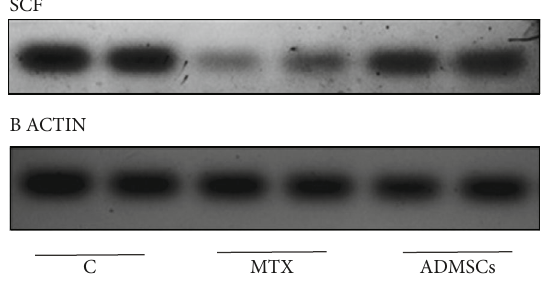
Figure 8: Western blot assay of SCF in homogenized testicular